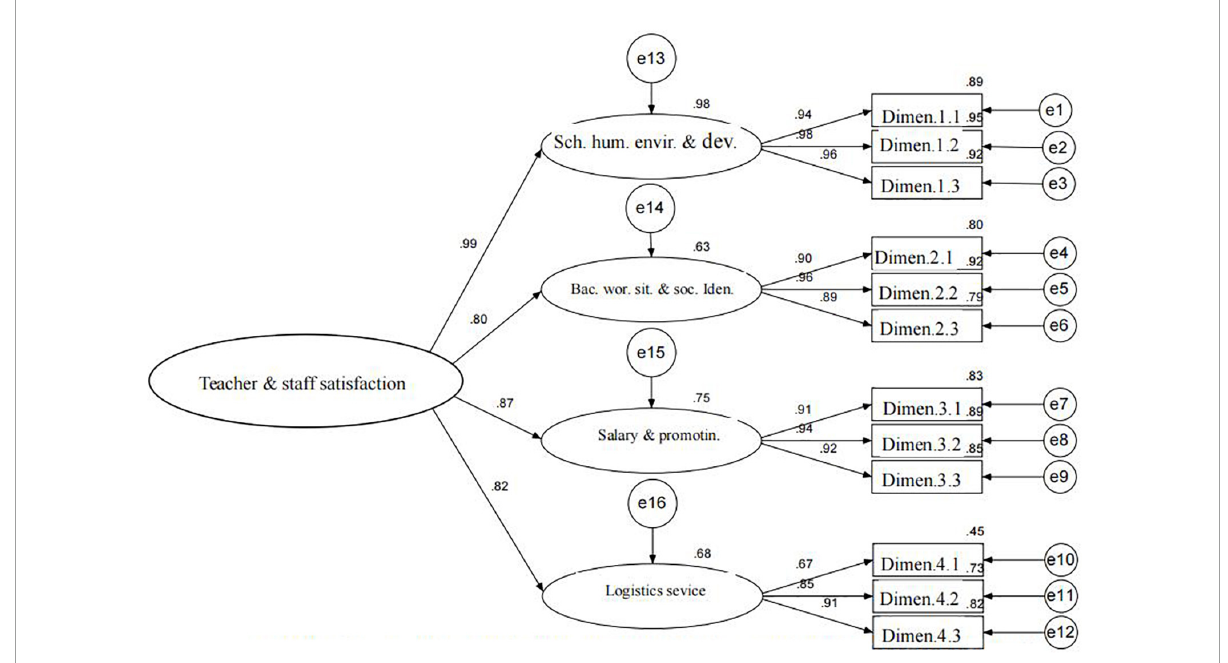
FIGURE4 Standardized estimation model of Chinese University teacher and staff satisfaction